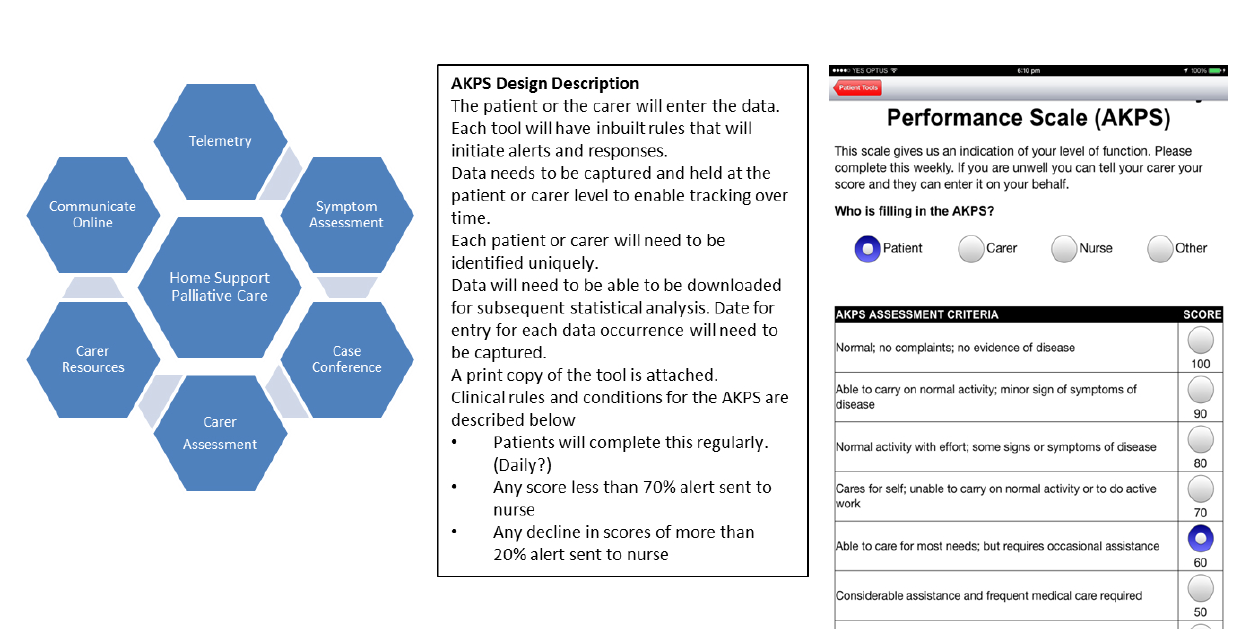
Figure 2. Development from concept ideation to functional clinical description to